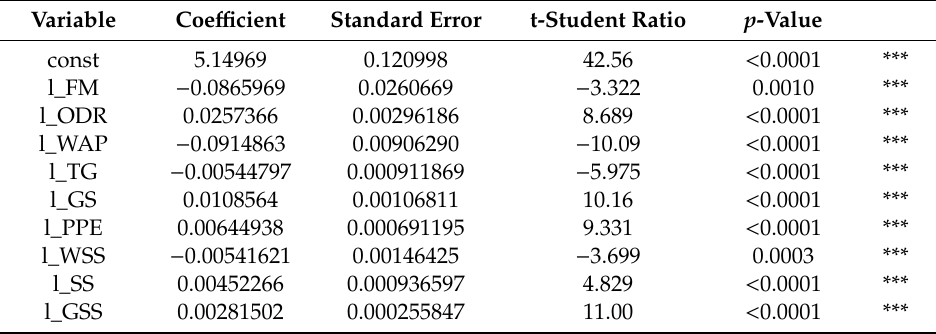
Table 8. OLS model 2 (dependent variable LE(f) =